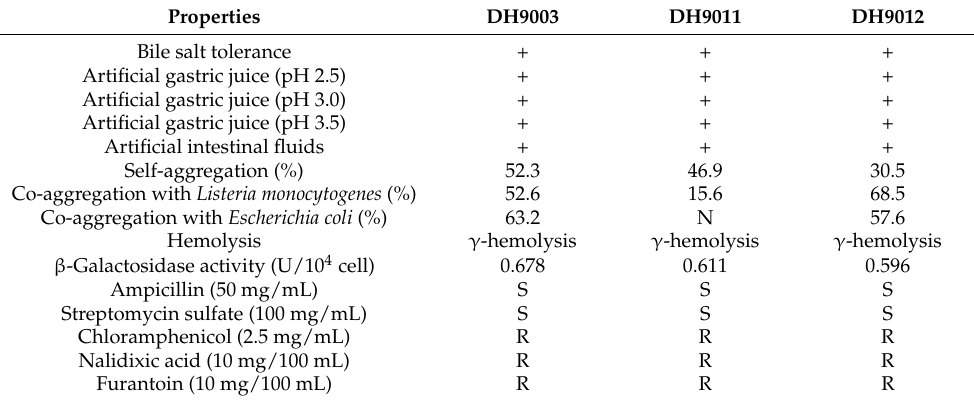
Table 3. Probiotic properties of three bacteriocins producers from lactic acid